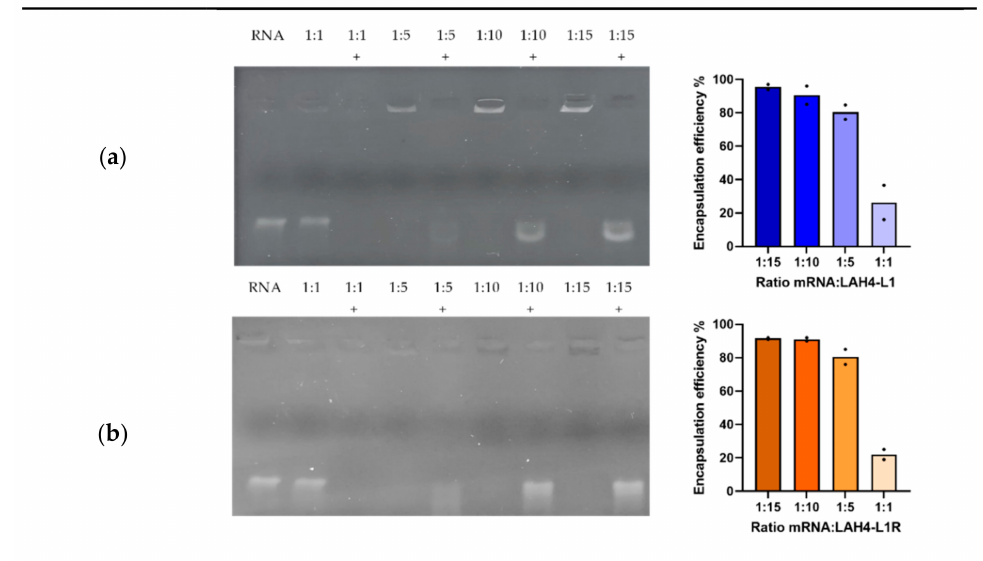
Figure 1. Encapsulation efficiency of histidine-rich peptides: mRNA was complexed to LAH4-L1 ( a ) or LAH4-L1R ( b ) at the indicated ratios ( µ g mRNA: µ g peptide) and subjected to treatment with RNase A and proteinase K (indicated with a “+”). mRNA released from the complexes was visualized by gel electrophoresis (representative result, n = 3). The percentage encapsulation efficiency was determined based on the amount of free mRNA after complexation and the mRNA released from the complexes after treatment with proteinase K. mRNA concentration was determined with the Quant-it TM RiboGreen assay kit ( n = 2, mean, each dot represents one experiment).